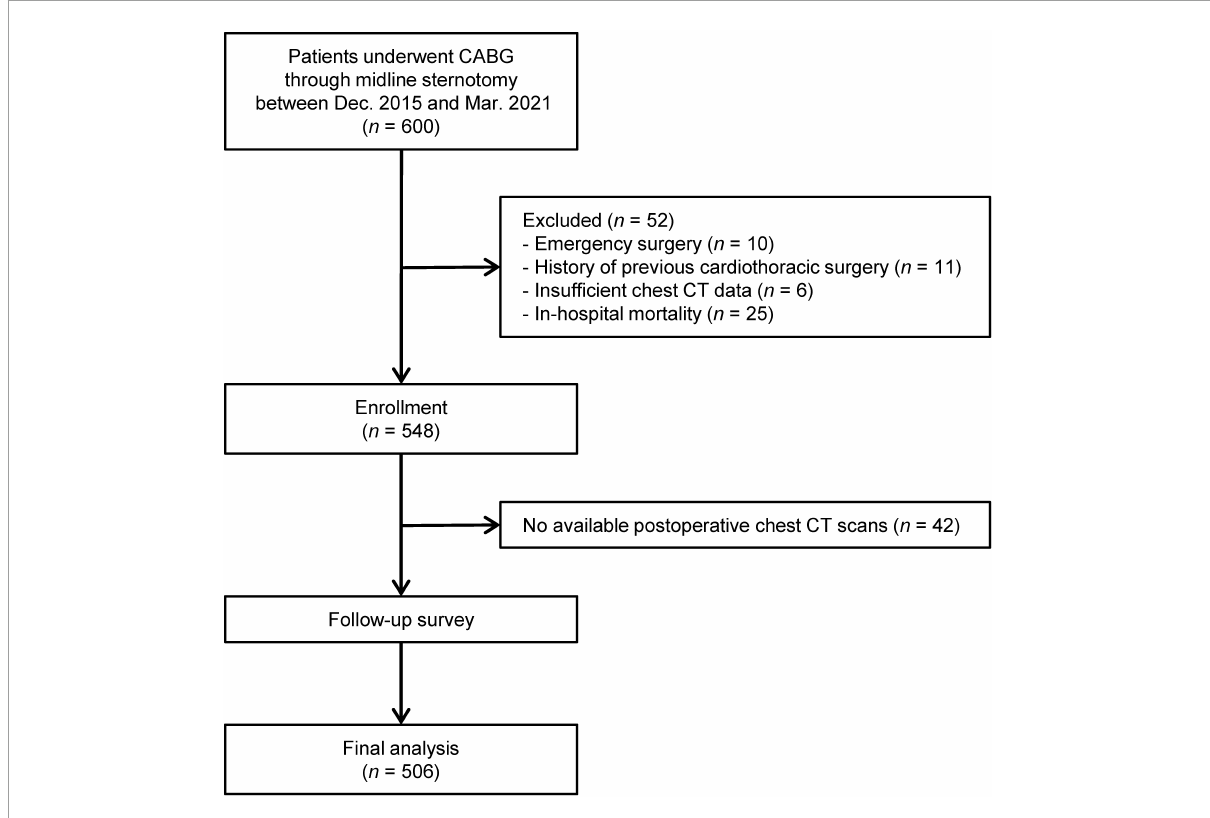
FIGURE1 Flowchart of patient